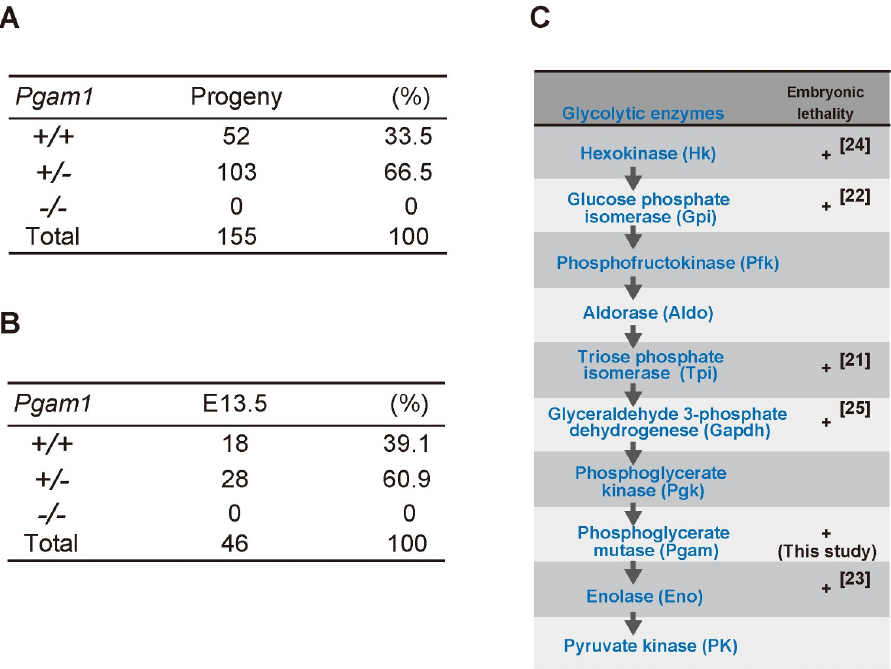
Fig 1. Embryonic lethality of homozygous knockout mice of Pgam1 . (A) Summary of Pgam1 genotypes for 155 progenies from crosses between Pgam1 +/− mice. +/+; wild-type, +/ − ; heterozygous KO, − / − ; homozygous KO. (B) Summary of Pgam1 genotypes for embryo from crossing between Pgam1 +/− mice at embryonic day 13.5 (E13.5). (C) Schematic diagram of glycolytic pathway. (+) indicates embryonic lethality in homozygous knockout mice, as reported previously (ref.